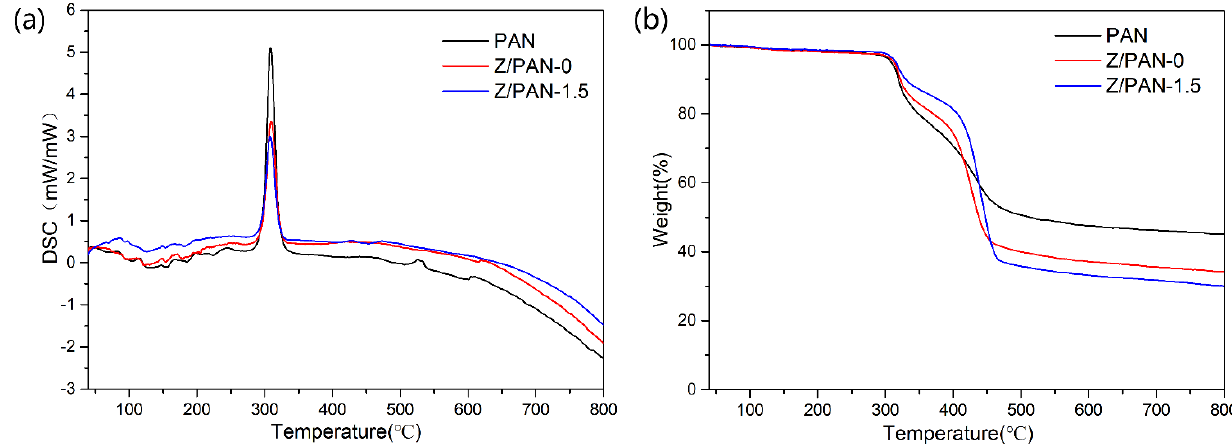
Figure 6. ( a ) DSC and ( b ) TG curves of the PAN separator, the Z/PAN-0 and Z/PAN-1.5 separator.